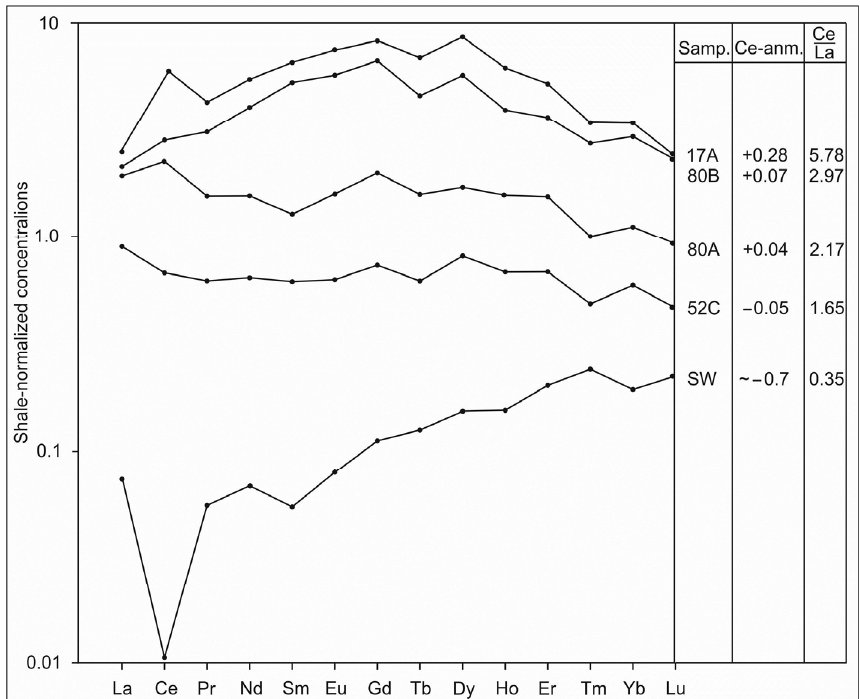
Figure 8. Rare earth elements distribution patterns in selected Early Turonian phosphate samples compared to seawater pattern. Sample 17A: phosphate nodule (Pecínov), data from Reference [11], Samples 80A and 80B: phosphate tube-fill (B ř ezinka–Chvalka) (present work), Sample 52C: phos- phatized carbonate clasts (Nová Ves), data from Reference [11], SW: seawater x 100, data from Reference [56].